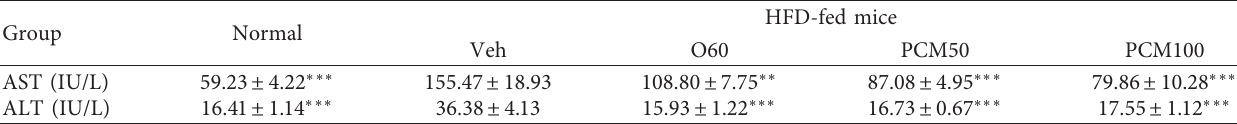
Table 3: The effects of PCM on serum hepatic functional parameters.